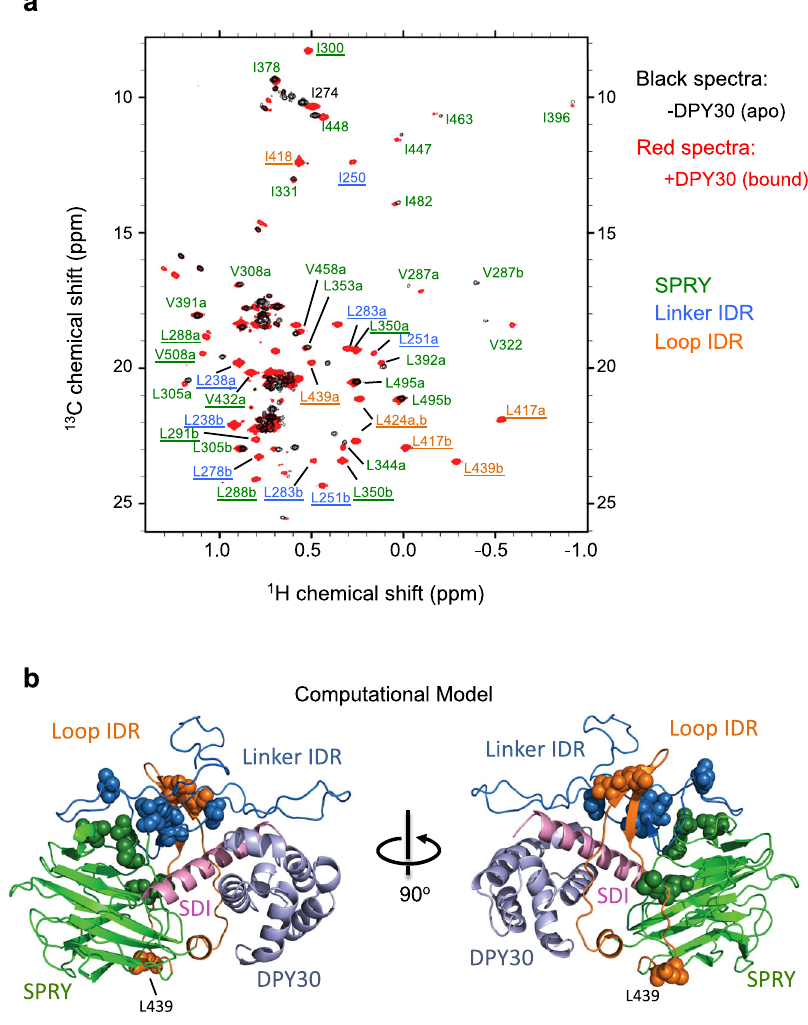
Fig. 4 ASH2L IDRs undergo signi fi cant conformational changes upon DPY30 binding. a DPY30 binding induces drastic conformational change in ASH2L. Superimposed methyl-TROSY spectra of [ 2 H, 13 CH 3 -ILV] ASH2L 202 – 534 in the absence (black) or presence (red) of DPY30. The labels indicate assigned residues in the DPY30-bound state. Underlined residues are newly appeared peaks upon DPY30 addition. b Computation model for ASH2L IDRs after DPY30 binding. Underlined residues in ( a ). are presented as spheres. These residues clustered together into a compact structure in this model. For both a and b , SPRY domain is shown in green, Linker IDR is shown in blue, Loop IDR is shown in